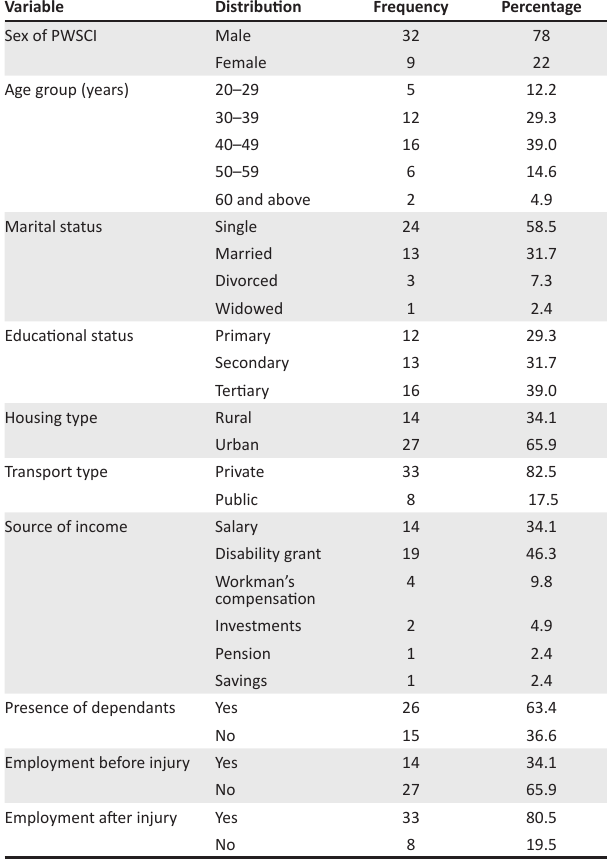
TABLE 1: Socio-demographic and clinical characteristics of the participants ( n =